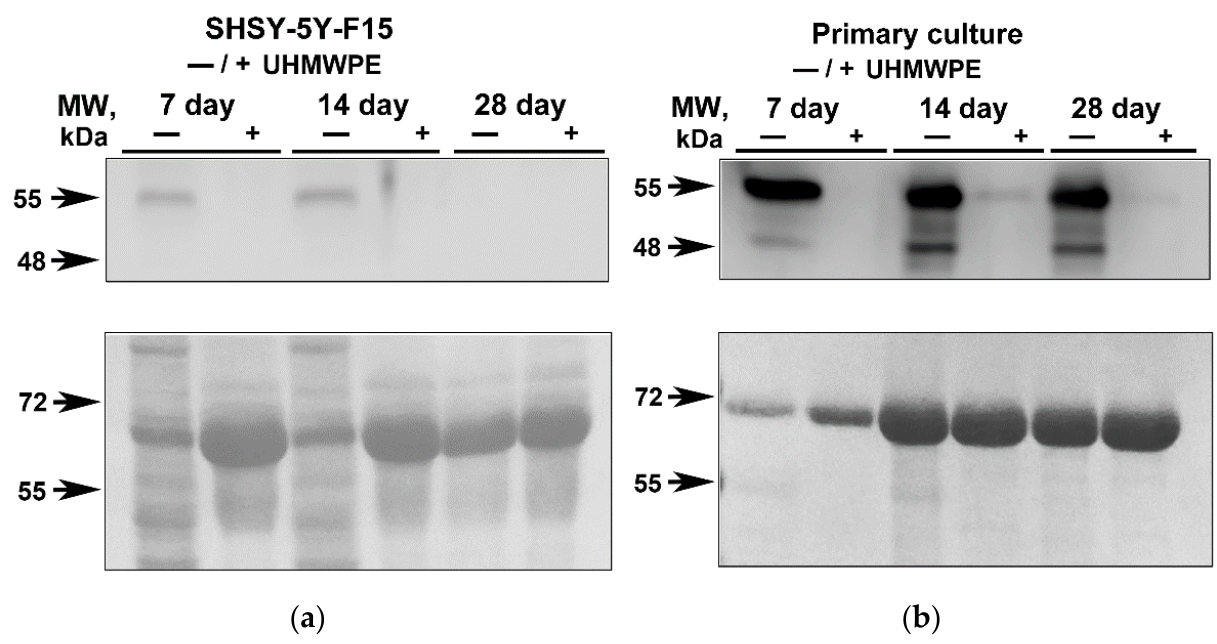
Figure 3. Detection of cytoplasmic GFAP level in cells seeded in 2D ( − ) compared to UHMWPE (+). ( a ) WB result for GFAP after 7, 14 and 28 days of human neuroblastoma cells (clone SHSY-5Y-F15); ( b ) WB result for GFAP after 7, 14 and 28 days in primary hippocampal cell cultures.